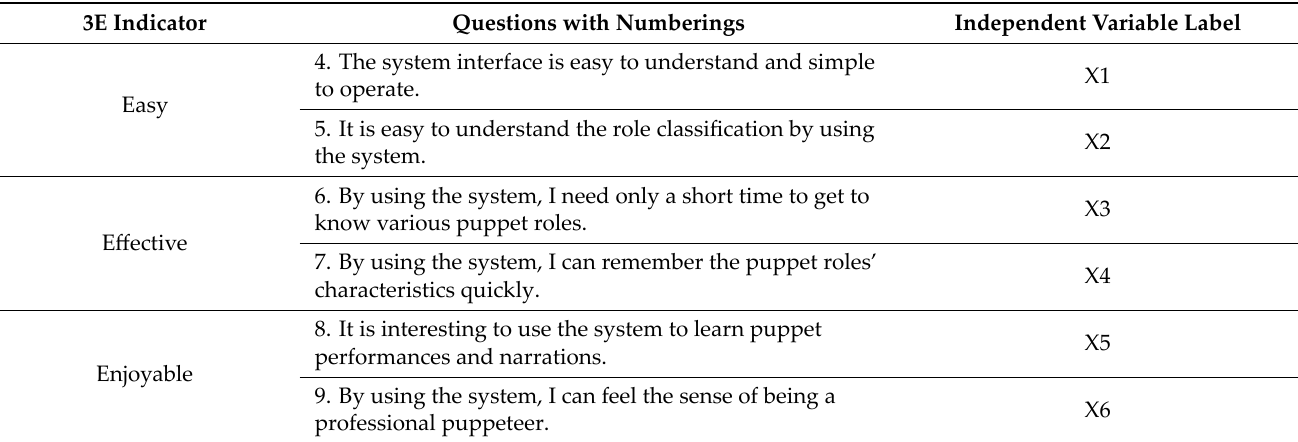
Table 10. The 3E indicators and the respective questions of the corresponding independent